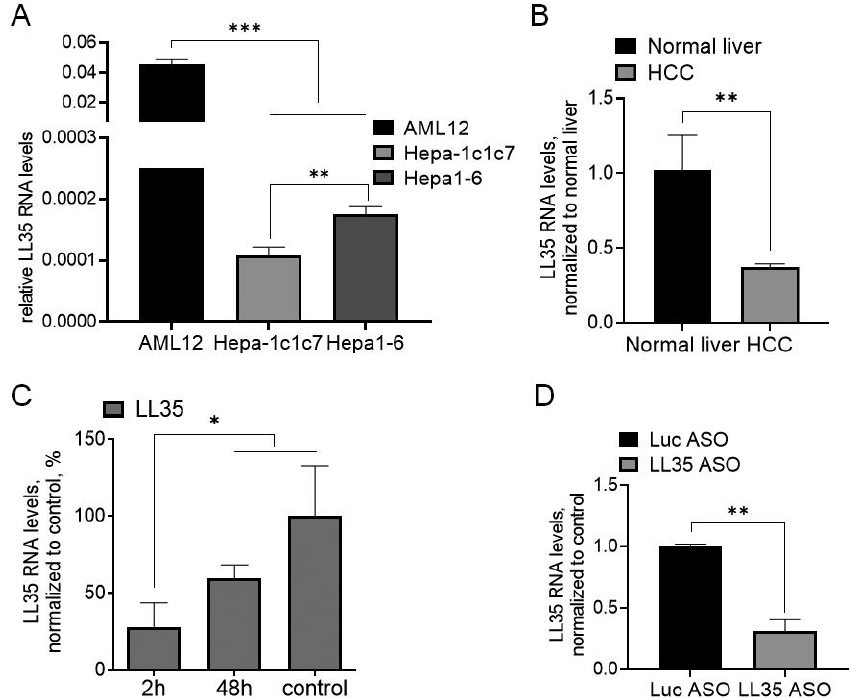
Figure 1. Evaluation of LL35 RNA levels in vitro and in vivo by RT-qPCR. ( A ) Hepatocyte cell lines. ( B ) Normal and HCC mouse liver. ( C ) Partial hepatectomy. ( D ) LL35 KD in the liver at day 5 after injection of GalNac-ASO conjugates (LL35 ASO). Luc ASO—control. ACTB—reference gene in RT-qPCR. Results show mean ± SD. * p < 0.05, ** p < 0.01 and *** p < 0.001.